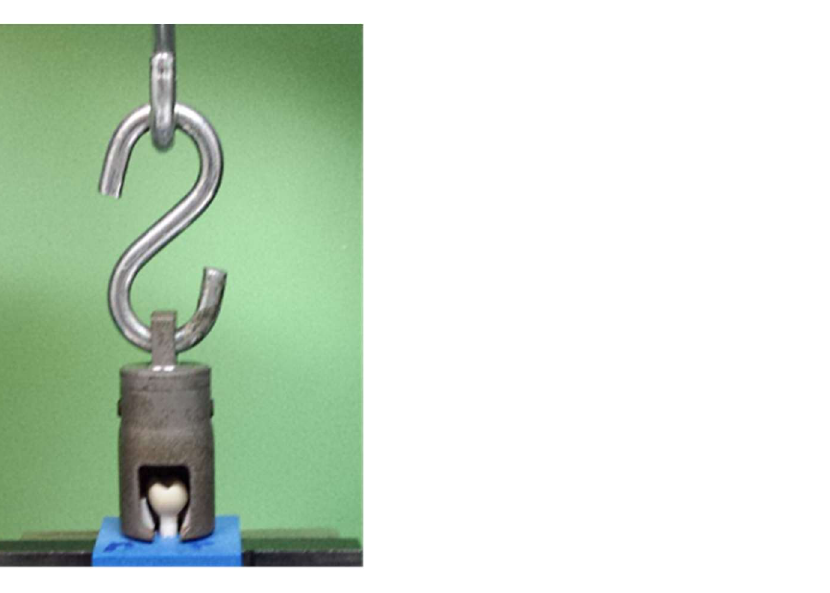
Figure 3. Trigger bell for the measurement of retention force, lined with a molded Teflon